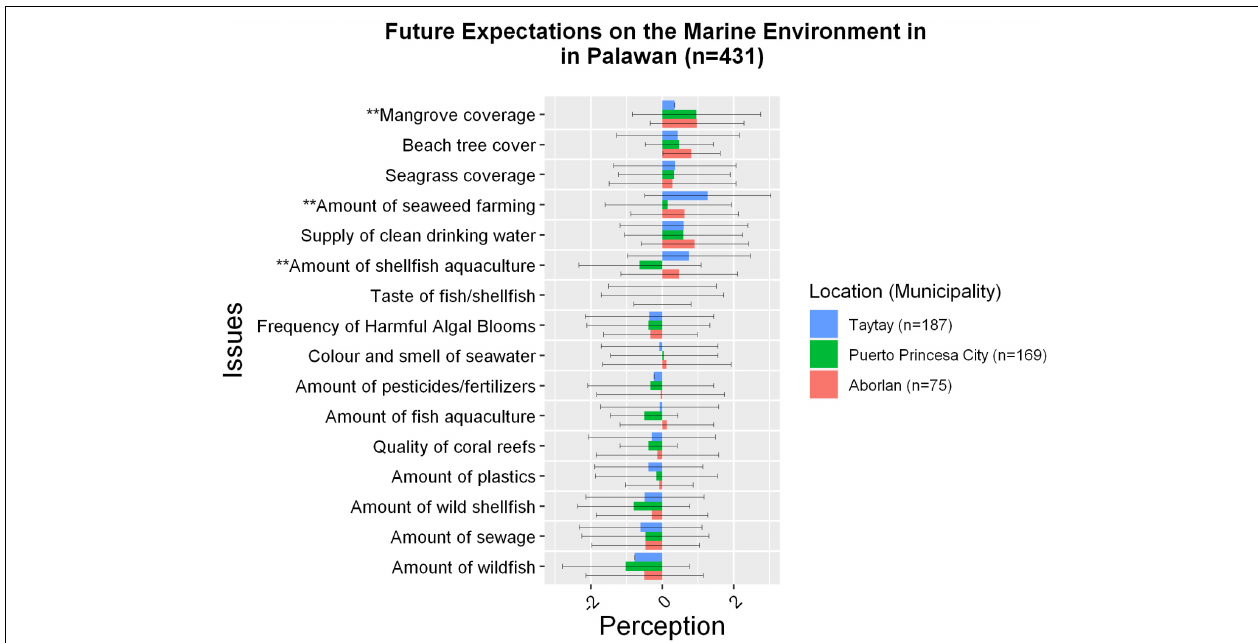
FIGURE 4 | Future expectations across different locations. Issues with ** are areas where high significant differences were observed ( p < 0.01). Issues with * are areas where significant differences were observed ( p <